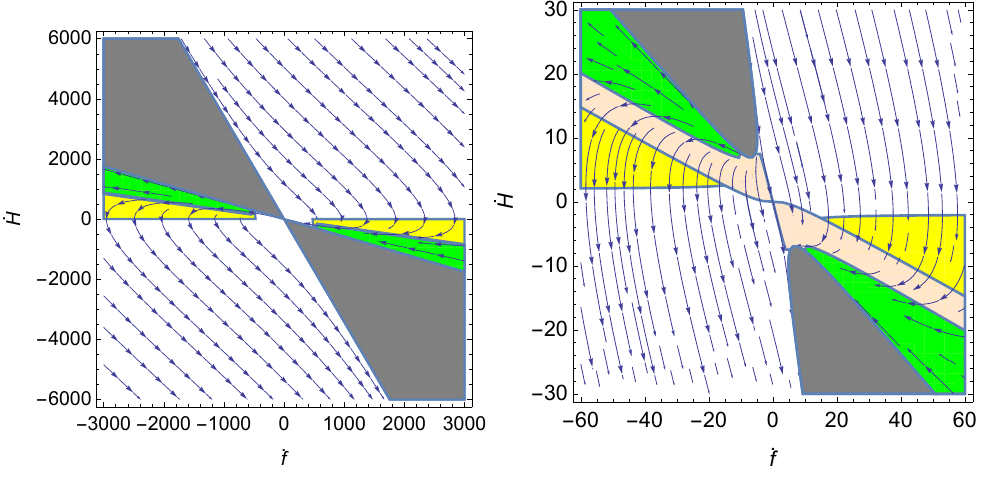
Figure 2 . The (cid:13)ow of solutions with e (cid:0) 2 f = X (cid:0) : white ( (cid:127) f > 0, (cid:127) a < 0, (cid:127) H < 0), yellow ( (cid:127) f < 0, (cid:127) a < 0, (cid:127) H < 0), light orange ( (cid:127) f < 0, (cid:127) a > 0, (cid:127) H < 0), green ( (cid:127) f < 0, (cid:127) a > 0, (cid:127) H > 0).